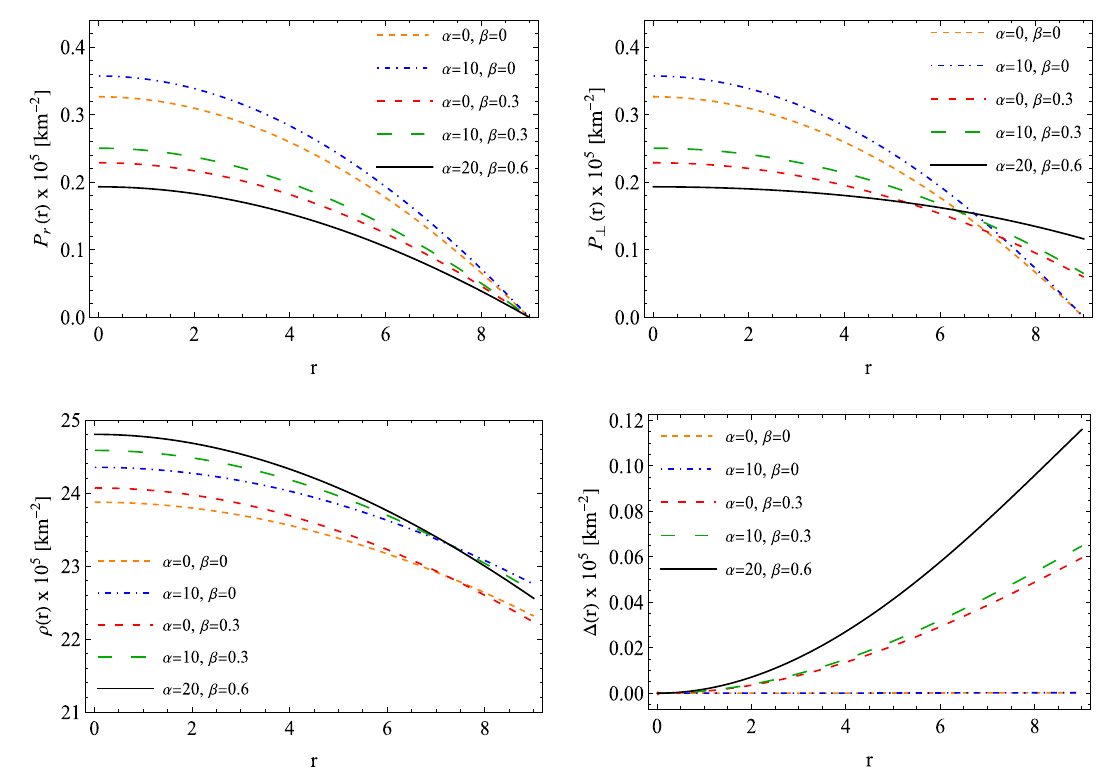
Fig. 4 The behavior of radial pressure P r ( r ) - top left, tangential pressure P ⊥ -top right, energy density ρ( r ) -bottom left, anisotropy factor (cid:2)( r ) -bottom right versus radial coordinate r for the solution Sect. 3.2